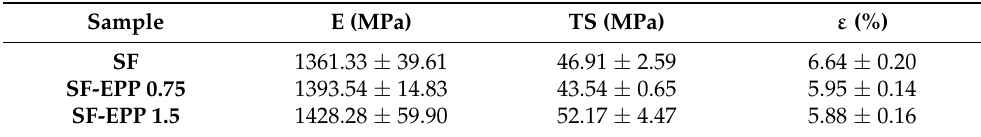
Table 1. Mechanical parameters determined at T = 23 ◦ C and 33% RH.